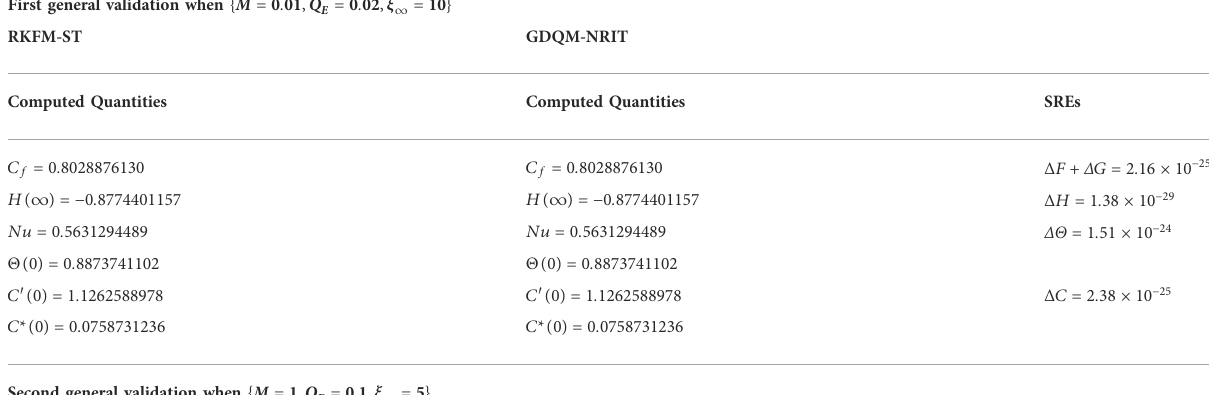
(cid:3) 0 . 2 ,E (cid:3) 1 , N (cid:3) 0 . 1 ,Sc (cid:3) 1 , N (cid:3) 70 T B